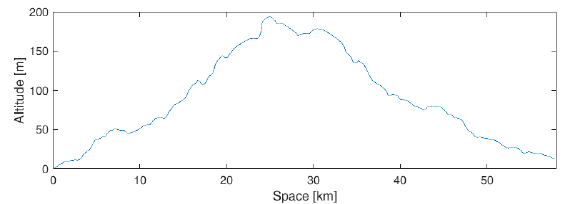
Figure 17. Altitude profile, extra-urban 2.